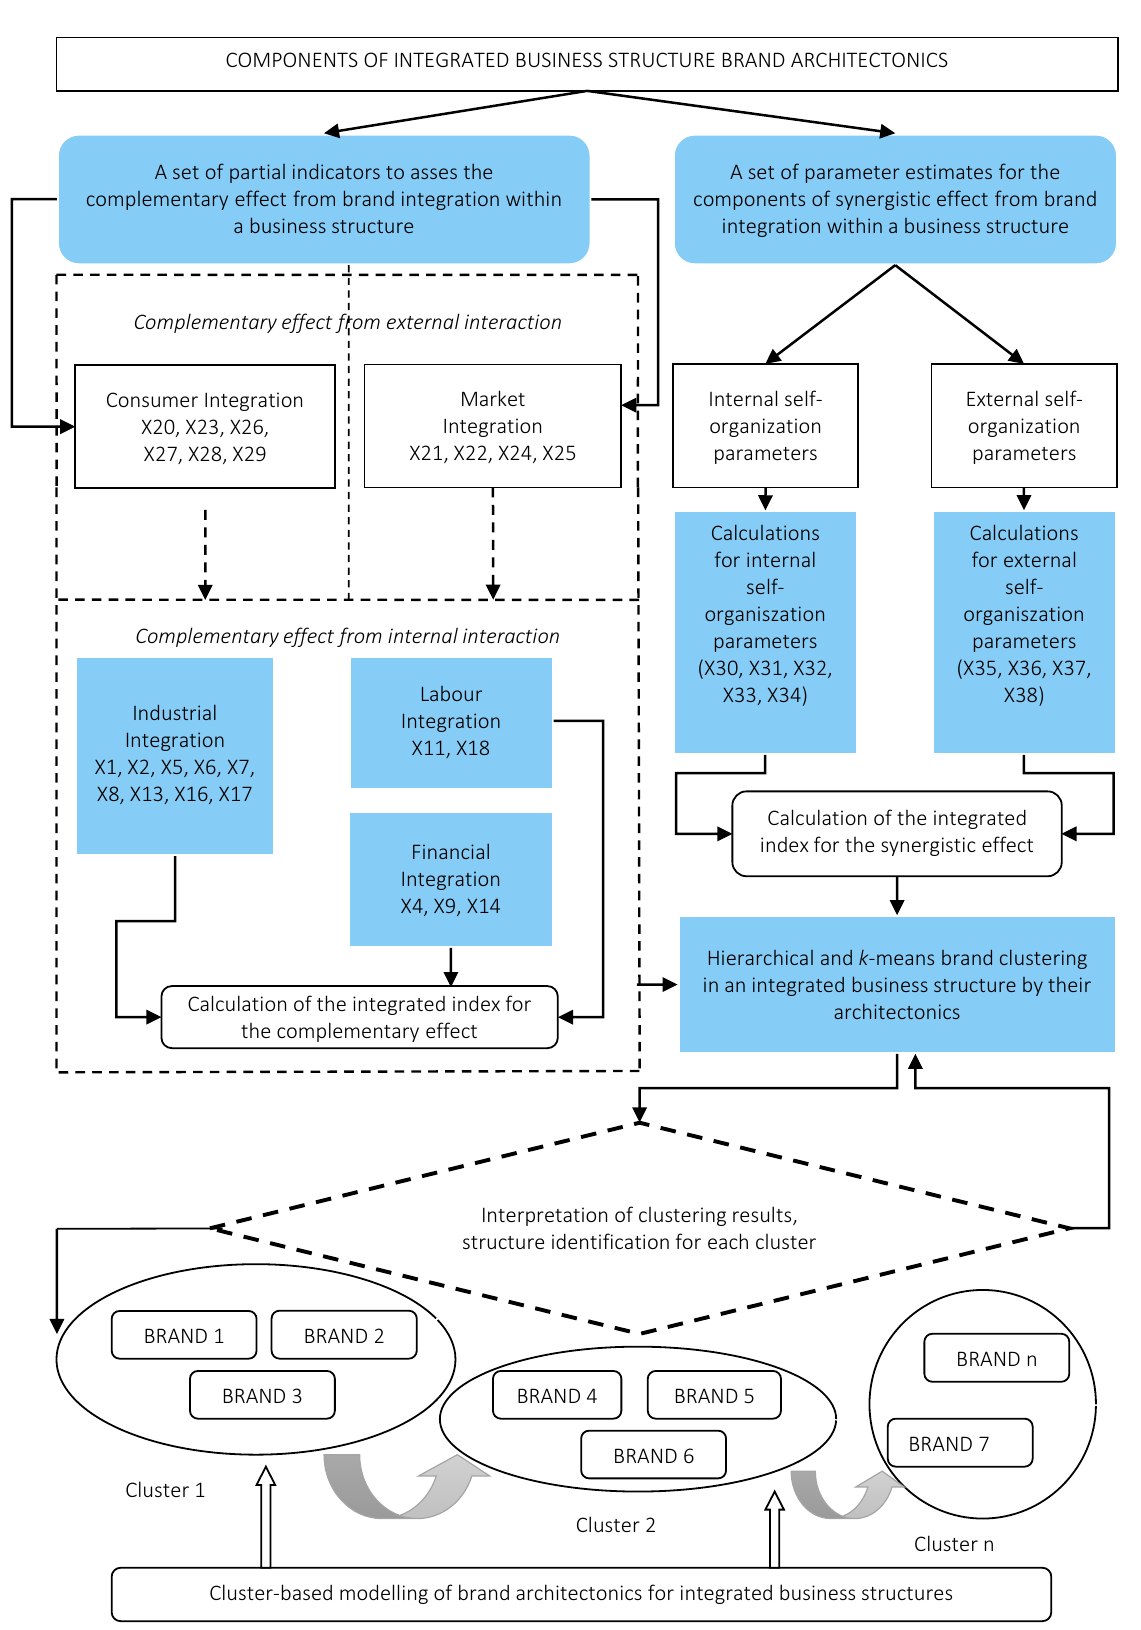
Figure 1. Methodological approach to integrated business structure branding